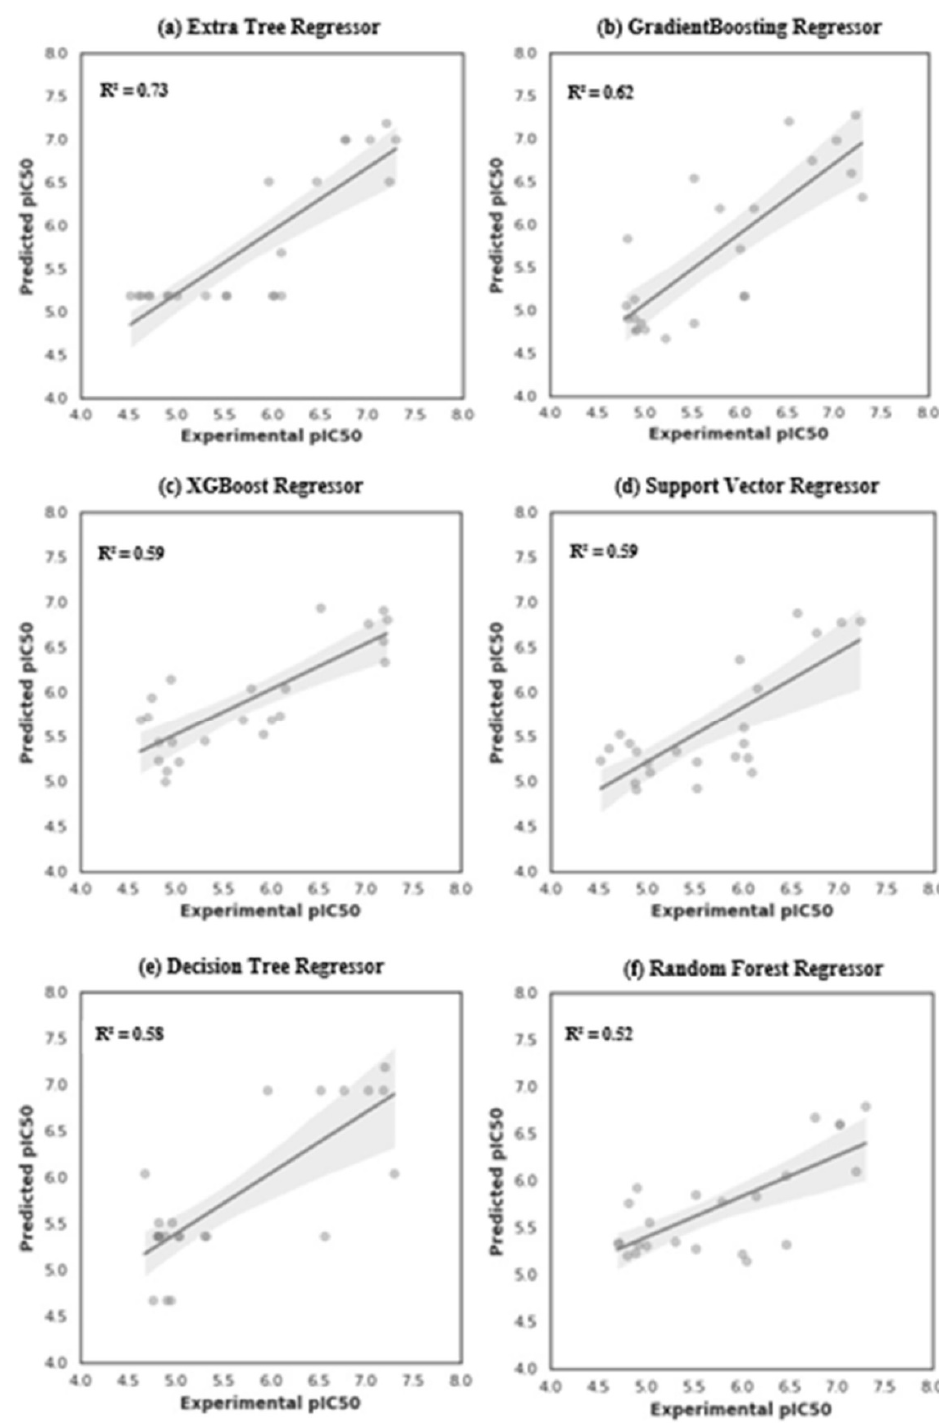
Figure 4. Plots of experimental versus predicted pIC50 for the ETR, GBR, XGBR, SVR, DTR, and RFR models.